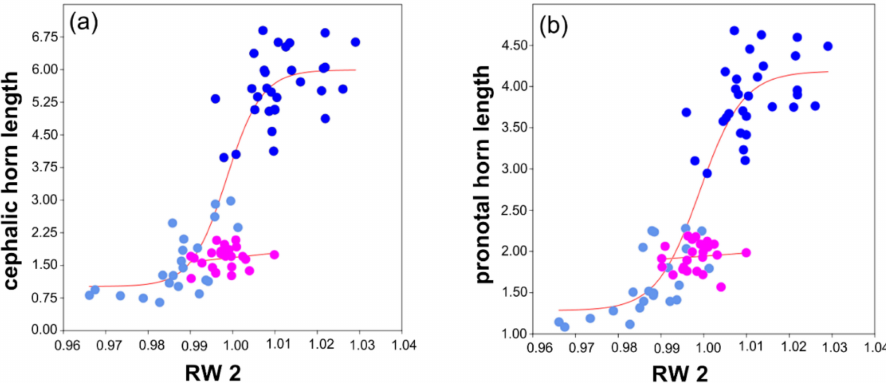
Figure 4. Size vs. shape analysis. ( a ) Scatterplot of the RW_2 and cephalic horn length with the best fit line, with the AIC value being 40.570 (Hill’s sigmoid function) for males, and 5.947 (linear function) for females. ( b ) Scatterplot of the RW_2 and pronotal horn length with the best fit line, with the AIC value being 19.895 (Hill’s sigmoid function) for males, and 5.227 (linear function) for females. In both plots, the morphs are distinguished by dark blue (major males), light blue (minor males) and fuchsia (females)